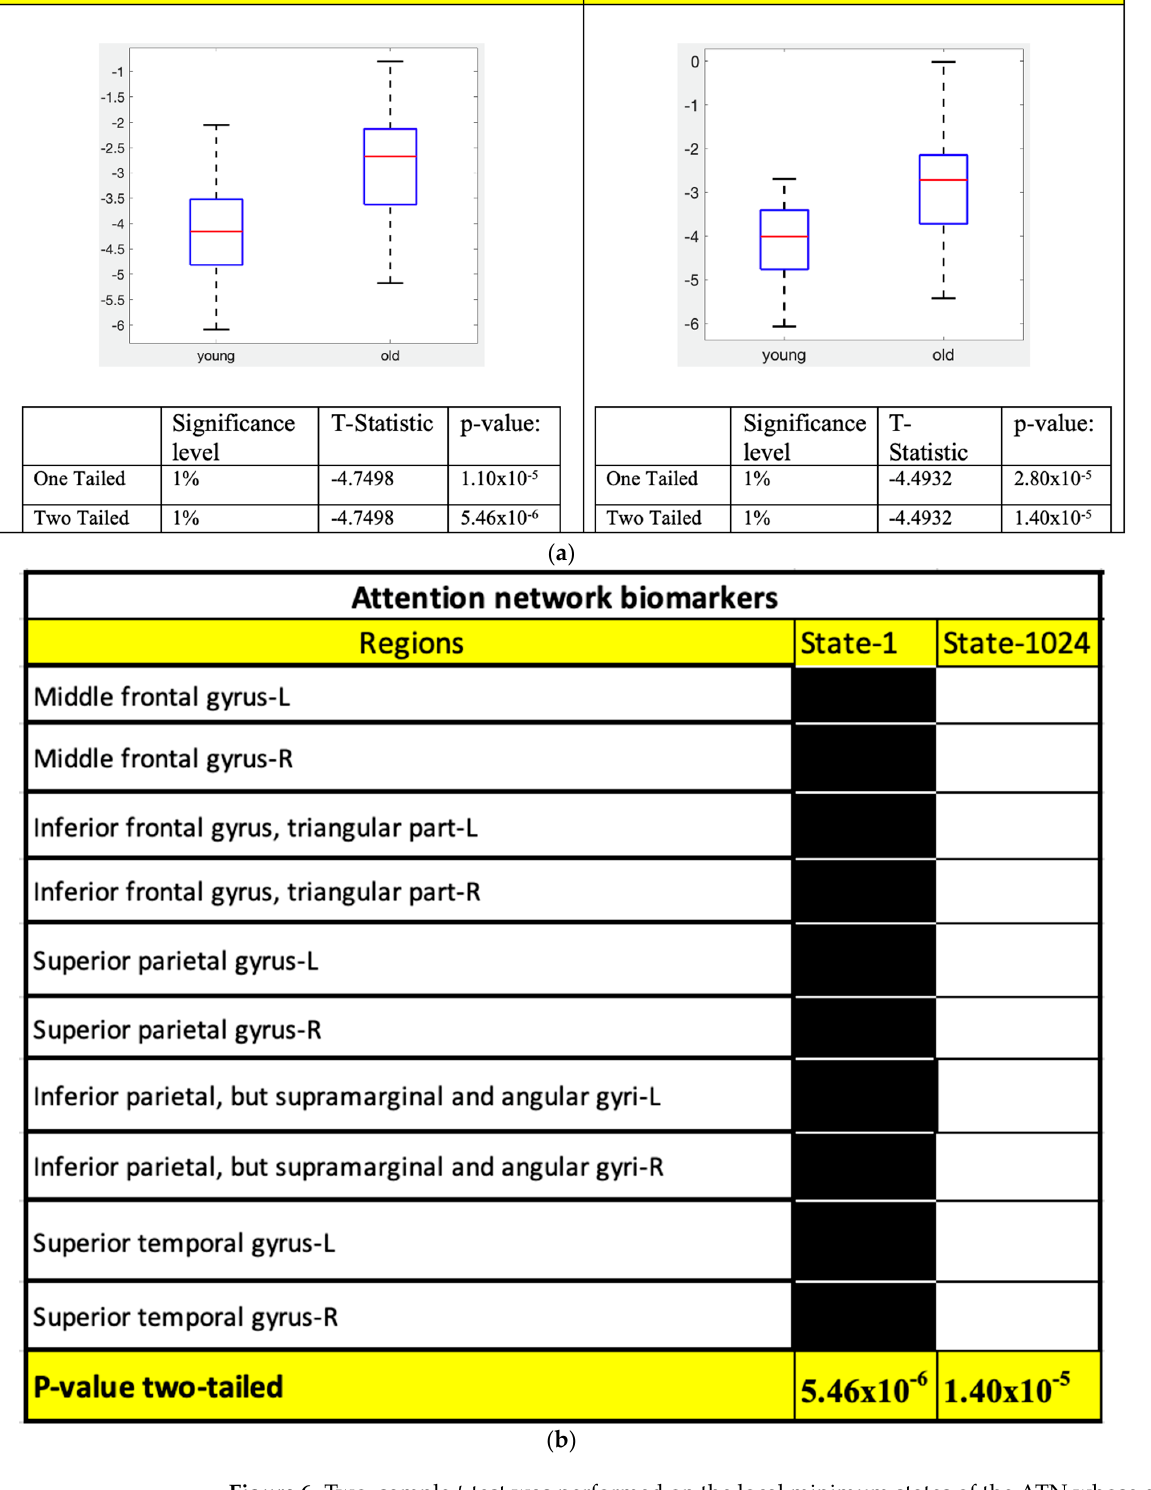
Figure 6. Two–sample t -test was performed on the local minimum states of the ATN whose energy difference was maximum and the states whose p –values satisfy the Bonferroni correction are con- sidered potential connectivity signatures. ( a ) Two–sample t -test results of the connectivity signature states for ATN. ( b ) Connectivity signature states definitions for ATN and ROIs functionality are shown to help interpret the meaning of these connectivity signatures.